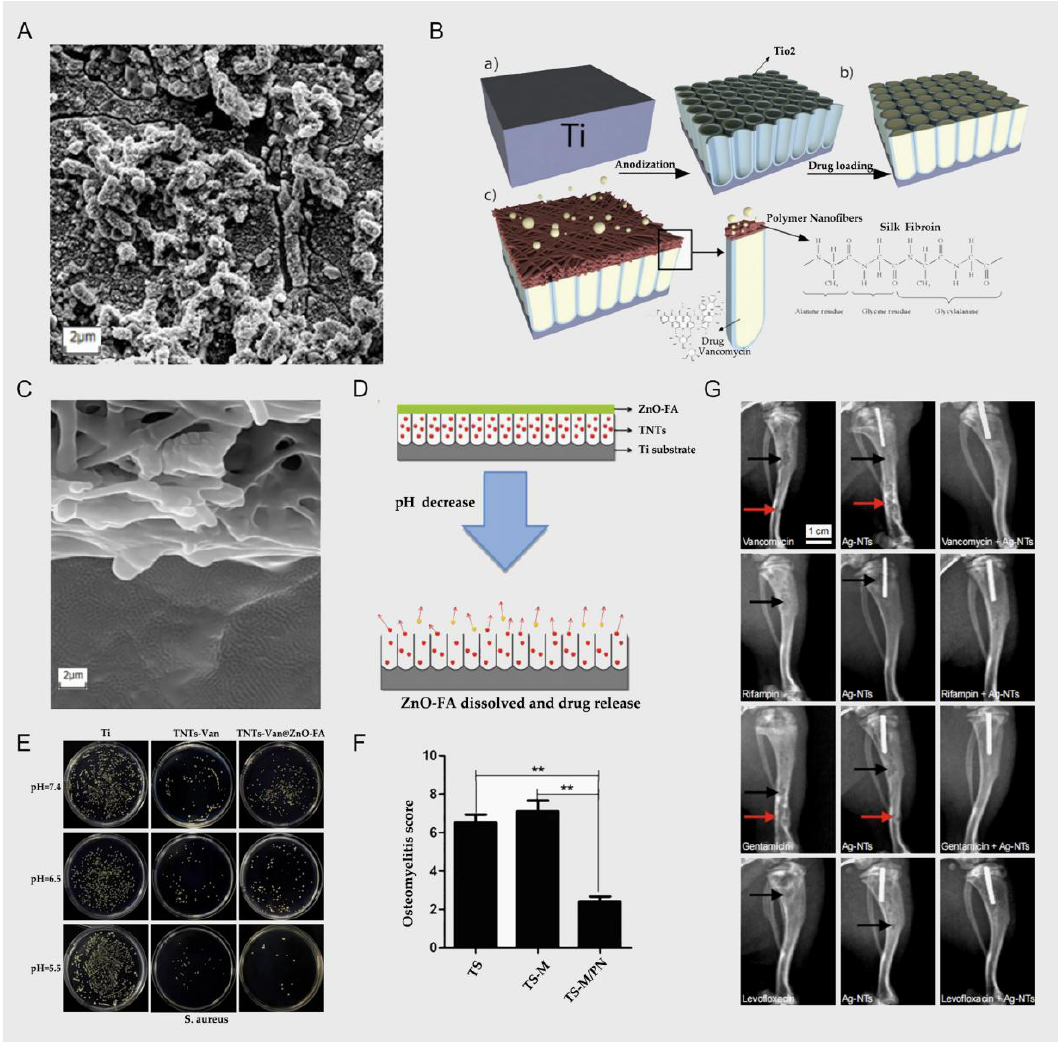
Figure 2. ( A ), P . aeruginosa biofilm on platinum; scale bar = 2 μm; reprinted with permission from [36] ; copyright 2020 Kirchhoff et al. ( B ) Experimental scheme of Fathi et al. ( a ) Bare TiO2-NTs layer created on Ti substrate by electrochemically anodizing; ( b )loading of Vancomycin within TiO2-NTs structures; ( c ) SF Nanofibers coated on TiO2-NTs to control Vancomycin release, antibacterial properties and enhance bone integration. The scheme presents a diffusion of Vancomycin molecules via SF Nanofibers; reprinted with permission from [42] ; copyright 2019 Elsevier B.V. ( C ) A cross-sectional image of the SF nanofiber coating on TiO2-NTs (along with loaded vancomycin); reprinted with permission from [42] ; copyright 2019 Elsevier B.V. ( D ) Experimental scheme of Xiang et al.; reprinted with permission from [44] ; copyright 2018 Elsevier B.V. ( E ) Different antibacterial activity between the experimental group and the control group at different pH values; reprinted with permission from [44] ; copyright 2018 Elsevier B.V. ( F ) The osteomyelitis scores of the experimental group and the control group (** denotes p ≤ 0.05); reprinted with permission from [29] ; copyright 2020 The Royal Society of Chemistry. ( G ) Images showing X-ray examination 3 weeks post-surgery; the rats in group I (antibiotic) and group II (Ag-NTs) exhibited classic symptoms of implant infection, including bone absorption (black arrow) and fibrosis (red arrow); the group III (Ag-NTs + antibiotic) rats showed no signs of infection; reprinted with permission from [45] ; copyright 2017 Dove Press Ltd.